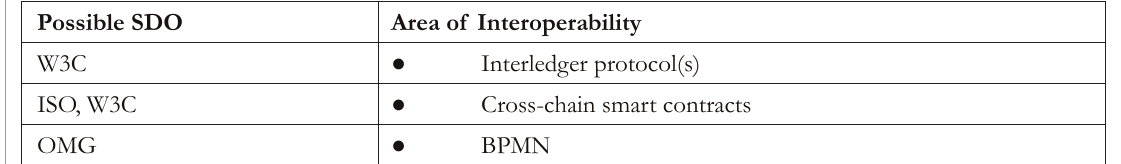
Table 5. Proposed Standards Development